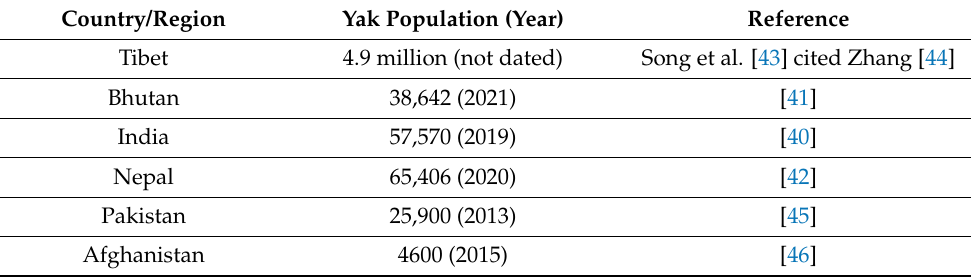
Table 2. Recent estimates of domestic yak populations in